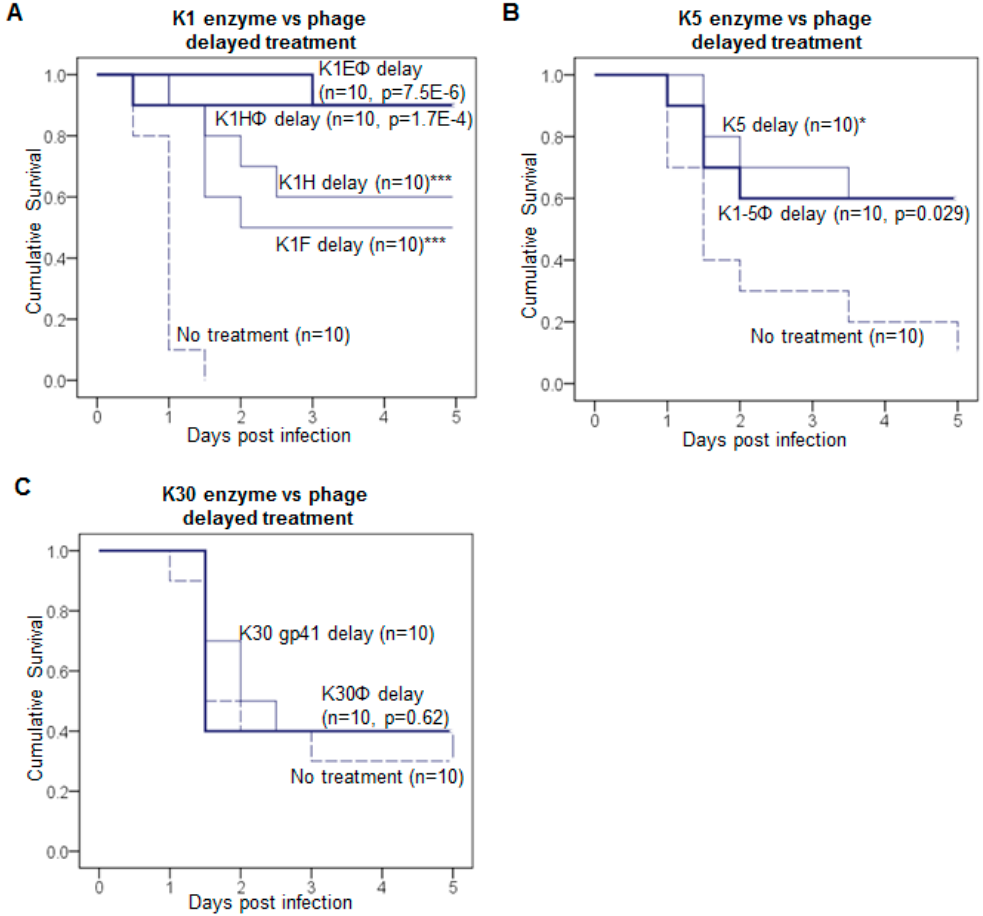
Figure 2. Comparison of depolymerases and cognate phages in treatment. Delayed treatments using phages were carried out in parallel to depolymerase. ( A ) K1E and K1H phage; ( B ) K1-5 phage; ( C ) K30 phage. Depolymerase data are from Figure 1. For phage treatment, mice were infected with intramuscular (IM) inoculations; 8 h later they received ~10 7 pfu phage IM in the contralateral thigh. For comparison to depolymerase treatment, this dose of phage carries about 3 × 10 − 5 µ g of depolymerase (see Methods for calculation). Kaplan-Meier survival curves were plotted as in Figure 1. The mouse number n of each treatment is labeled on each curve. Log rank test: p values for delayed phage treatments compared to the no treatment control are listed, or * p < 0.05, *** p < 0.001 for delayed enzyme treatment as in Figure 1.